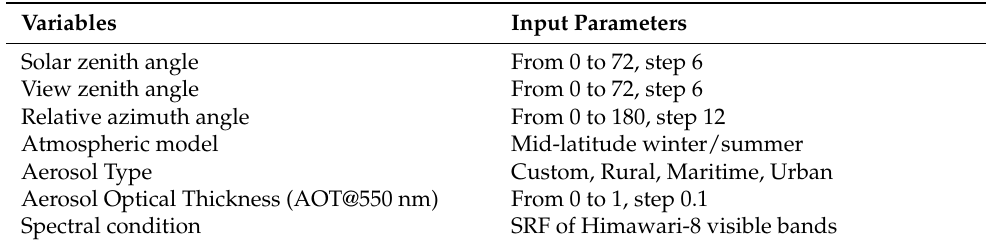
Figure 4. Radiance components estimated from 6S simulation. Time series around noon (10:30, 12:30, 14:30, and JST) are plotted with L 0 , L gd , L gi , and L pm at the CEReS site and built-in custom aerosol model (Data are from 2020). Table 2. Input variables and parameters for 6S model.